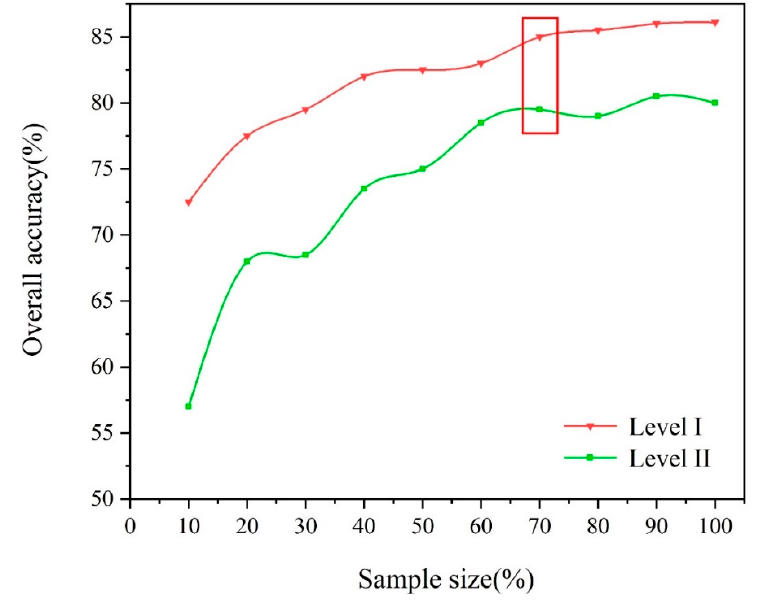
Figure 11. The variation of urban land use classification accuracy with the training sample size.